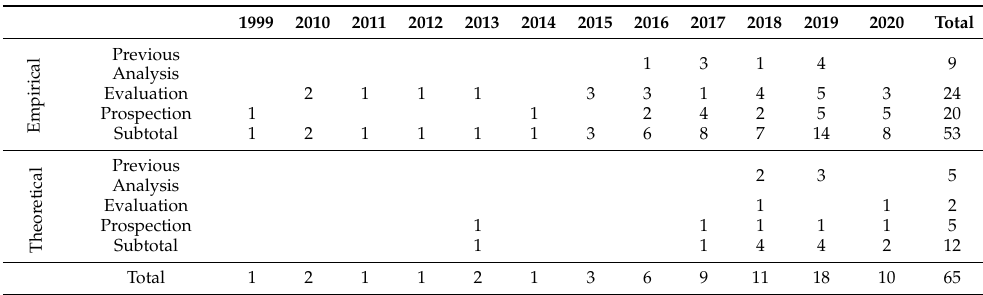
Table 3. Evolution of articles regarding the type of linked method and the objective of public policies identified in the